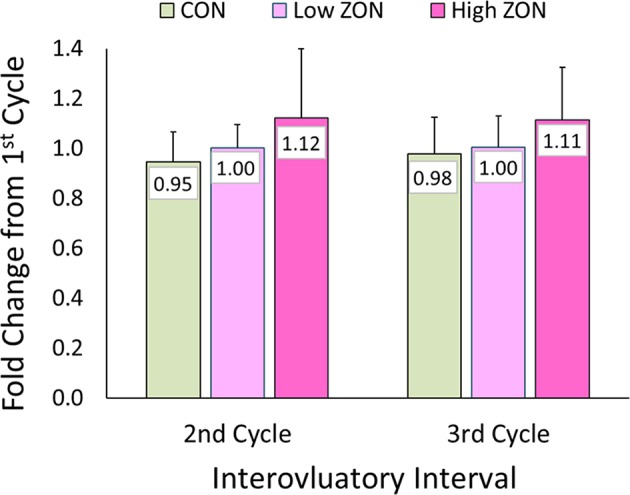
Change in interovulatory interval (IOI) with ZON treatment. Mean ratio ± S.D of each mare's 2nd and 3rd IOI to her initial IOI. Treatments: Control (n = 6), Low (n = 6), and High (n = 7). Low ZON treatment IOI does not include Mare #206 who exhibited a PCL in Cycle 2.